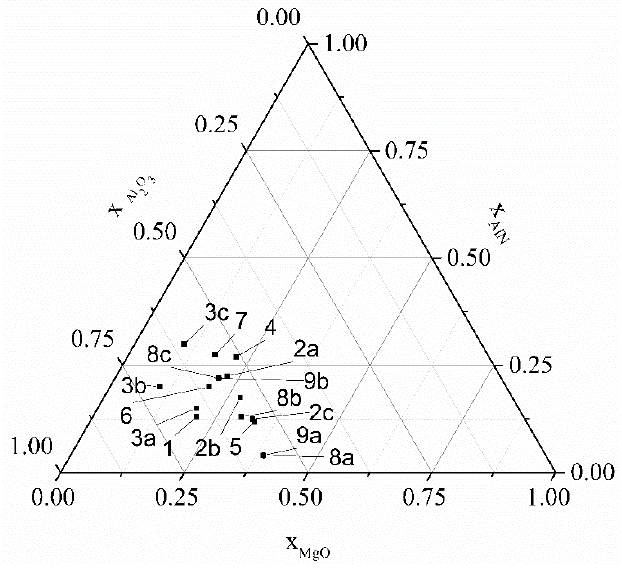
Figure 1. Starting compositions (mole fractions) for the synthesis of MgAlON from selected literature sources, specified in Table 1, shown in a simplified diagram of the ternary MgO-AlN-Al 2 O 3 system. Ma et al. [24] also reported MgAlON as the major phase after 2 h of pressureless sintering of a carbothermal mixture of 3.6 wt% carbon black, 88.6 wt% Al 2 O 3 , and 7.8 wt% MgO in flowing nitrogen at 1500 ◦ C, whereas single-phase MgAlON was observed at 1600 ◦ C. For an aluminothermal reduction using 51 mol% Al 2 O 3 , 22 mol% MgO, and 27 mol% aluminum powder as starting materials, Wang et al. [25] reported nearly single- phase MgAlON after holding the mixture at 1500 ◦ C for 3 h in flowing